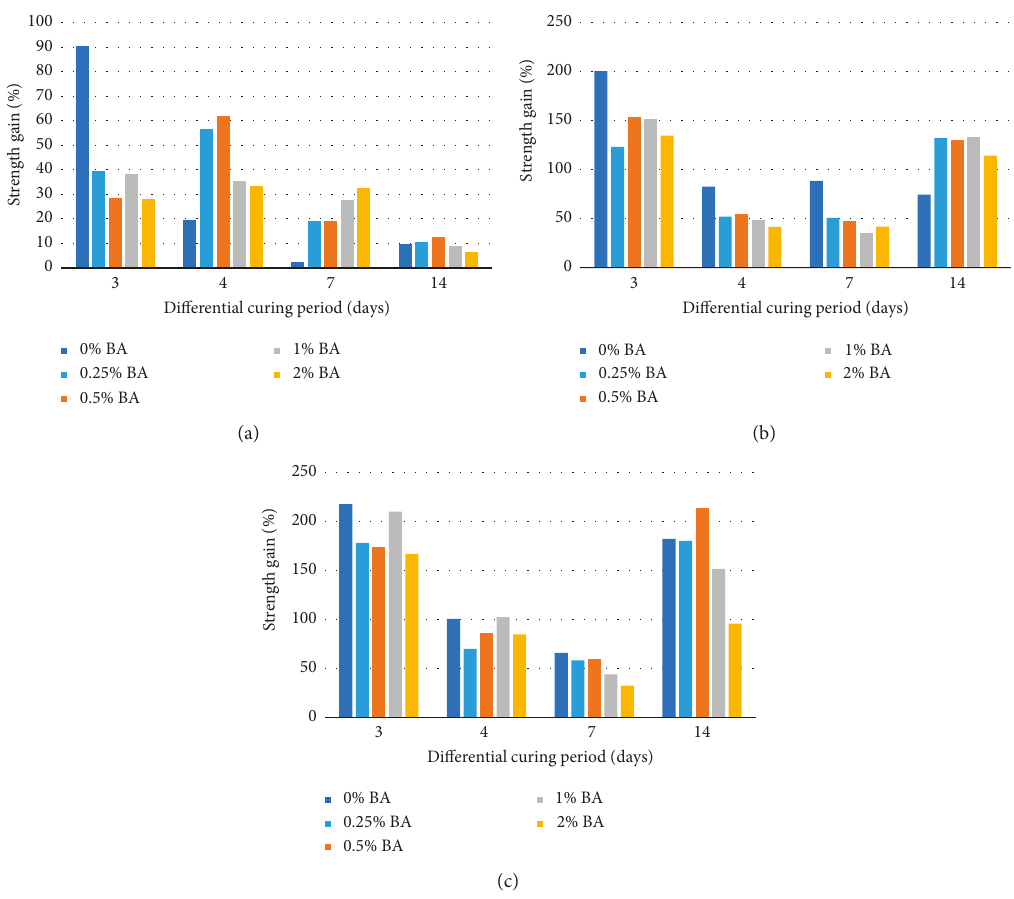
Figure 8: Percentage strength gain of (a) 3%, (b) 5.5%, and (c) 7% lime stabilized soil with curing